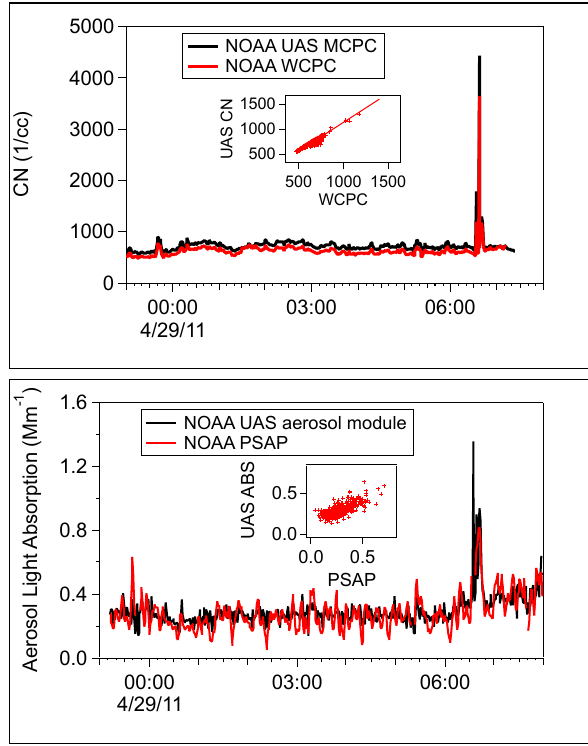
Figure 3. Ground bases comparison at Gruvabadet Laboratory in Ny-Ålesund of the MANTA 2 Fig. 3. Ground bases comparison at Gruvabadet Laboratory in Ny- aerosol light absorption coefficient (ABS) and total particle measurements (MCPC) with the 3 ˚Alesund of the MANTA aerosol light absorption coefficient (ABS) Radiance Research Particle Soot Absorption Photometer (PSAP) and a TSI water based CN 4 and total particle measurements (MCPC) with the Radiance Re- counter (WCPC). 5 search Particle Soot Absorption Photometer (PSAP) and a TSI wa- ter based CN counter